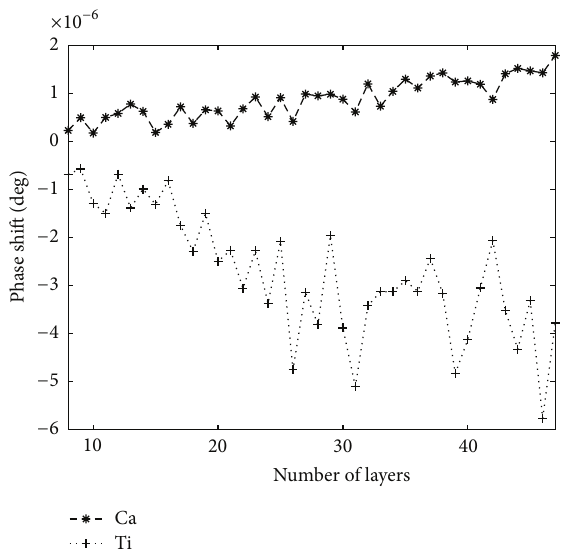
Figure 8: Difference between transmission at 187.5 MHz and 1GHz. Layers have a thickness of 2 cm (continuous line), 4 cm (dash-dotted line), and 10 cm (dotted line, marked by